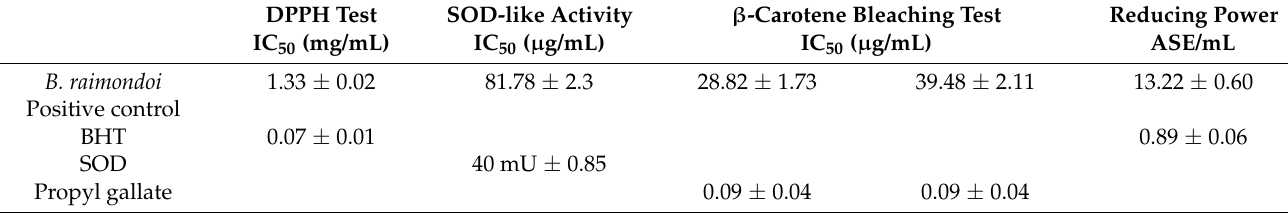
Table 4. Antioxidant activity in cell-free